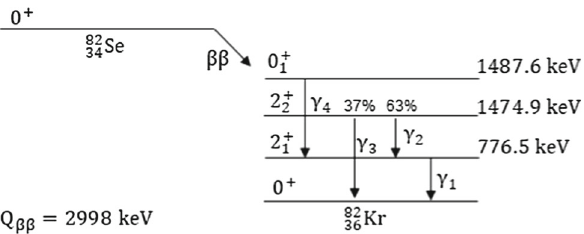
Fig. 1 Decay scheme of 82 Se to 82 Kr